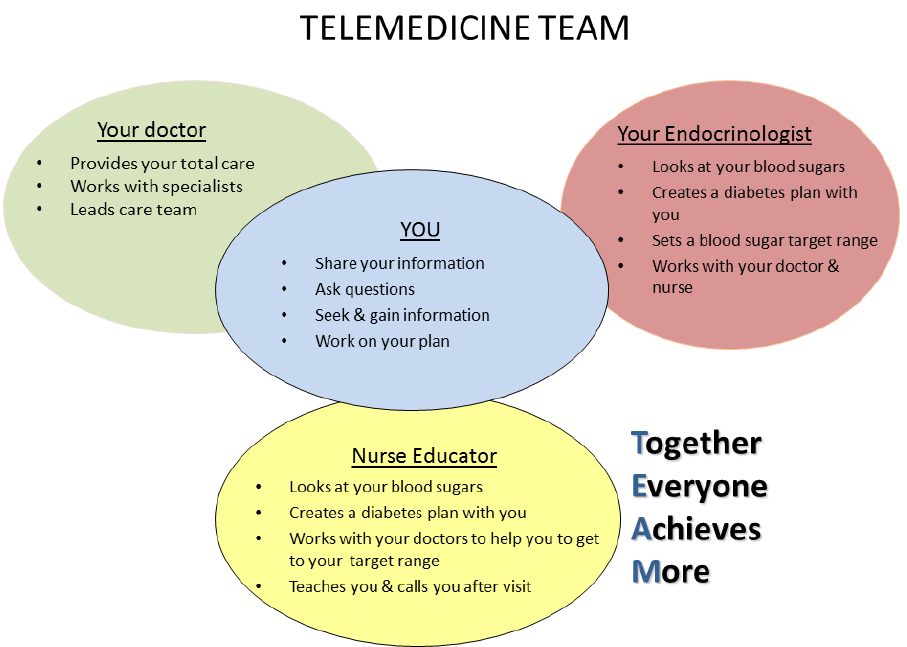
Figure 1. The TREAT team.